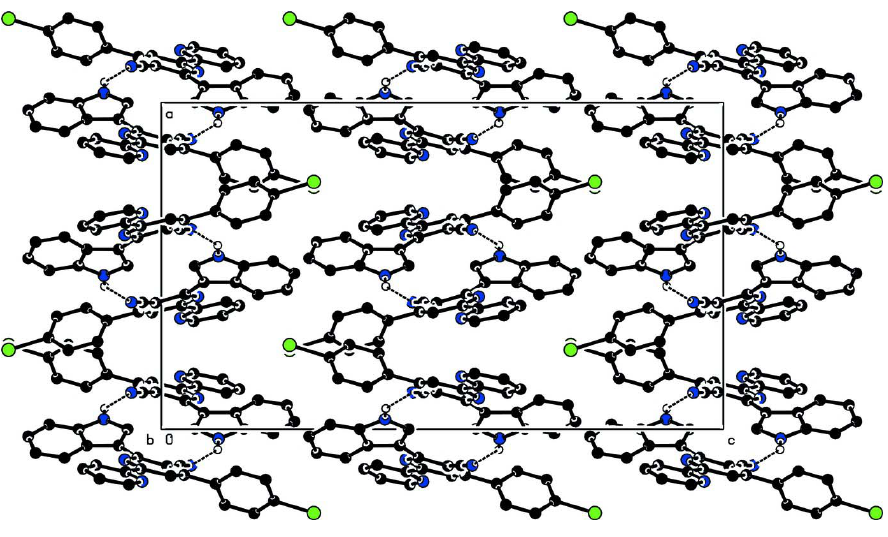
The crystal packing of the molecules viewed down the b axis. H atoms not involved in hydrogen bonding are omitted for